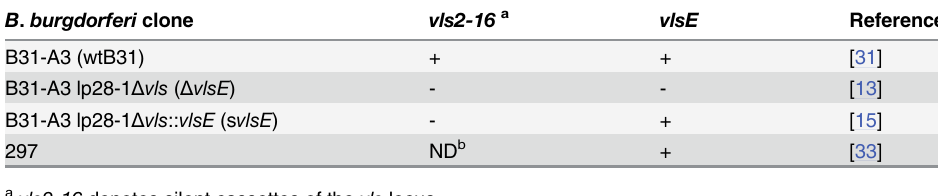
Table 1. B . burgdorferi clones used in the study.